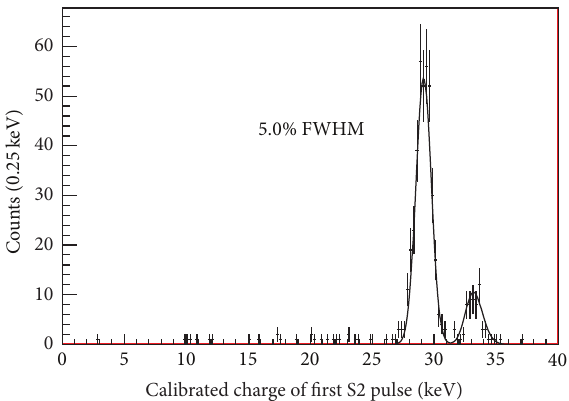
Figure 33: Energy resolution at 10atm for 30keV xenon X-rays [38].